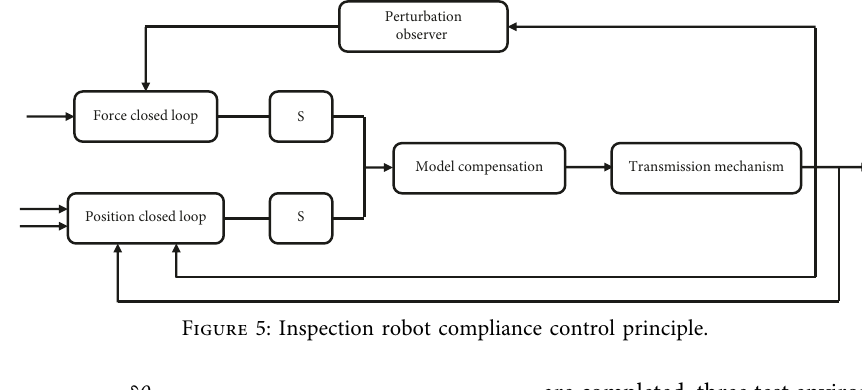
Figure 5: Inspection robot compliance control